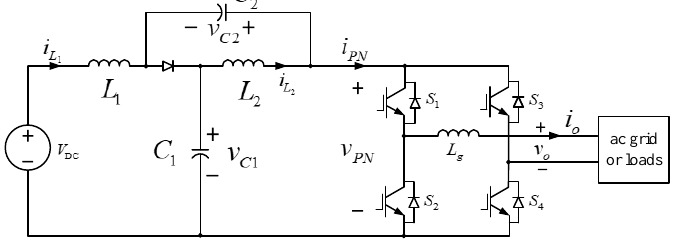
Figure 1. Single-phase quasi-Z-source inverter (QZSI).